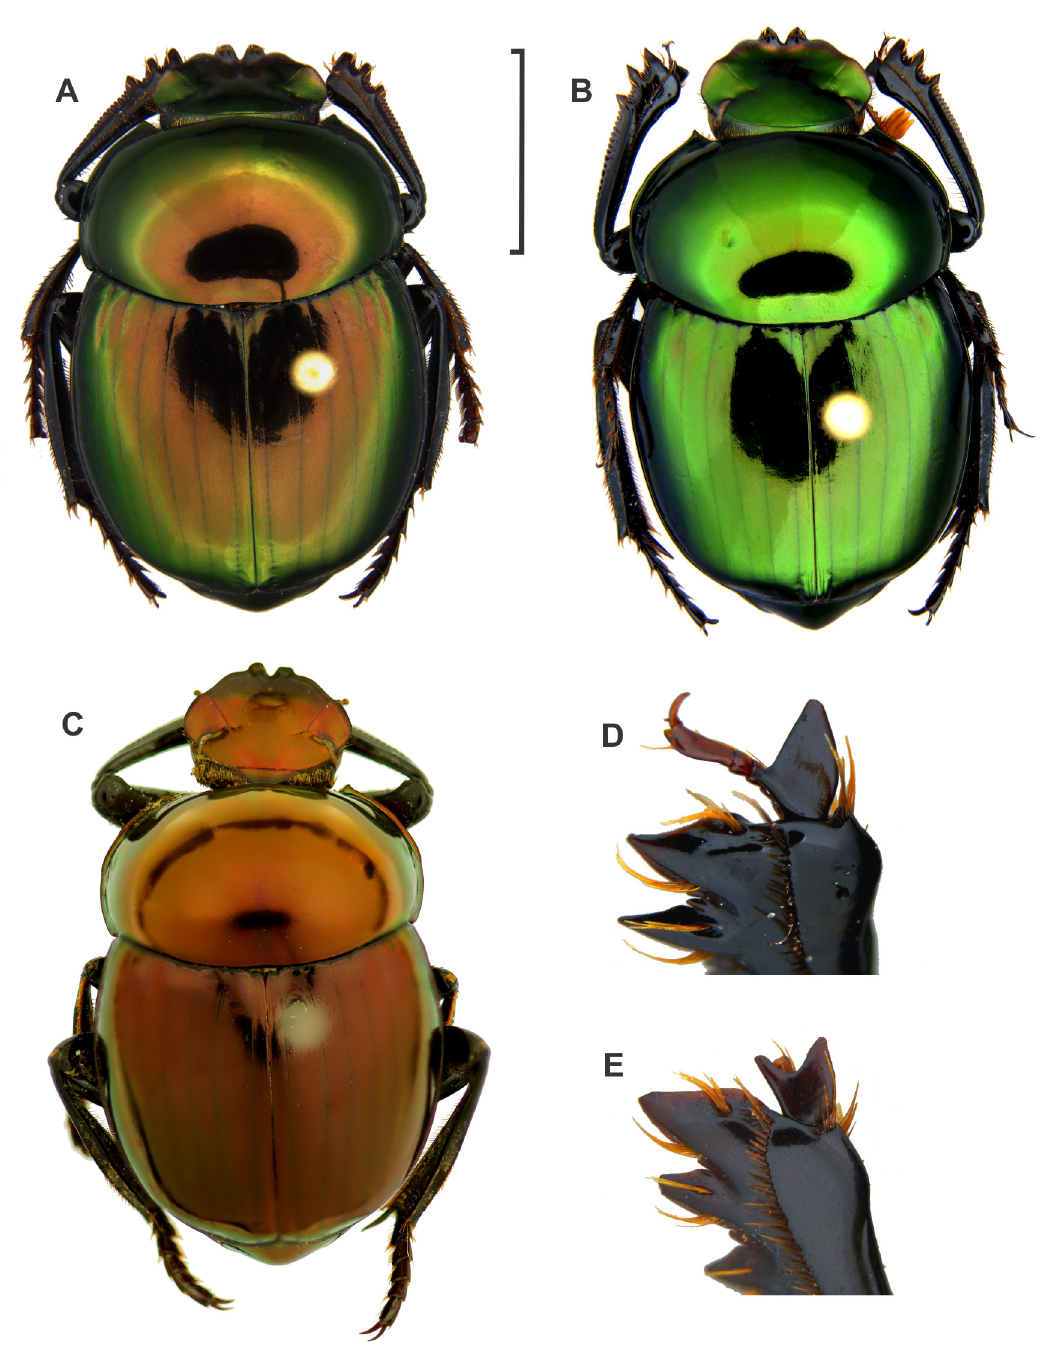
Fig. 3. A . Canthon (G.) fulgidus fulgidus Redtenbacher, 1868. B . C. (G.) fulgidus martinezi subsp. nov. C–E . C. (G.) fulgidus pereirai subsp. nov. D . Male protibial spur. E . Female protibial spur. Scale bar: A–C =